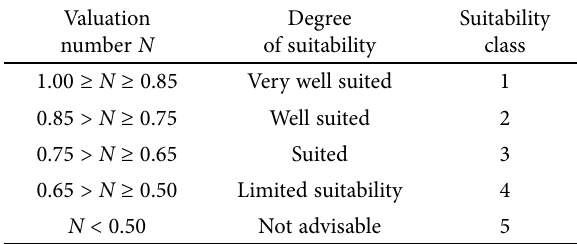
Table 13. Disintegration time t